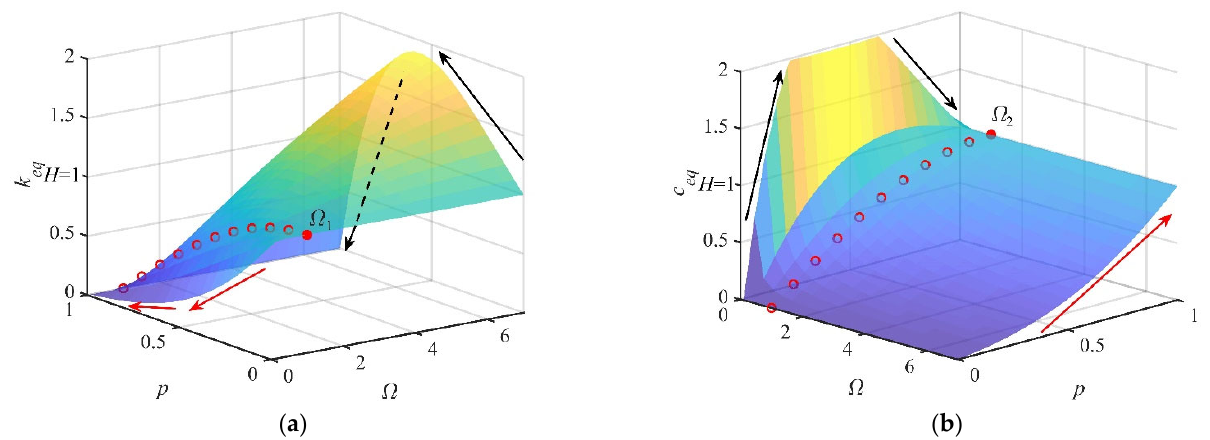
k ; ( b ) the equivalent damping co ‐ eq k . Figure 4b eq